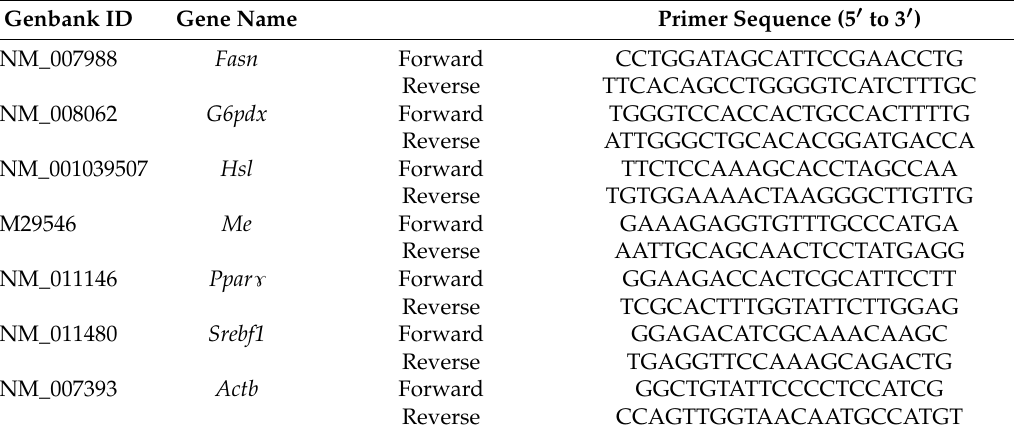
Table 2. Primer pairs used for the real time qRT-PCR